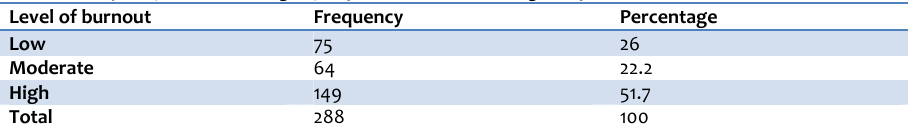
Table 4: Frequency and Percentage of Depersonalization among Sample Teachers Level of